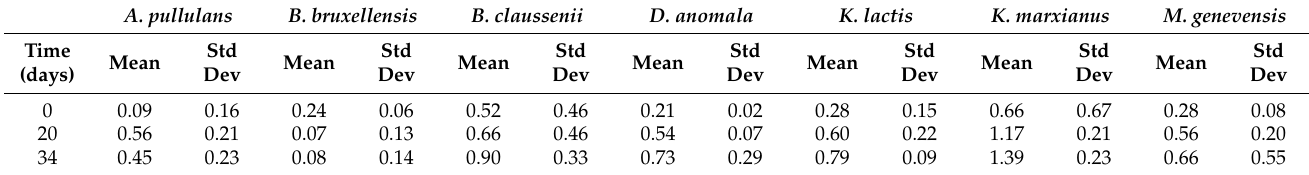
Table 3. Acetic acid concentrations under anaerobic fermentation